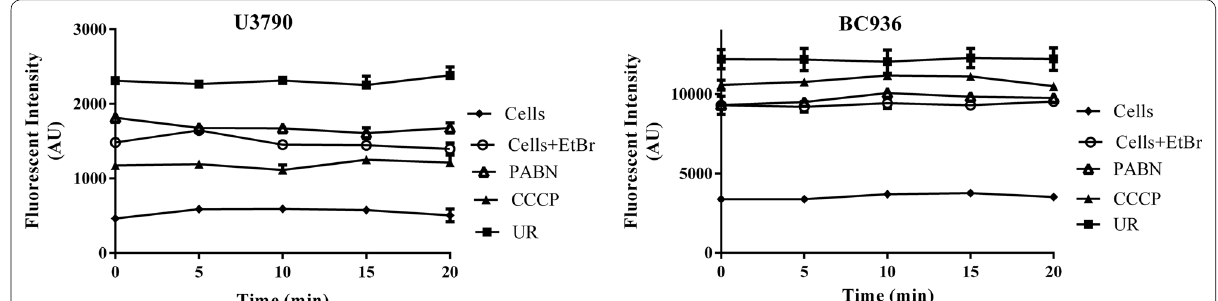
Fig. 4 Ursolic acid inhibits efflux pump in colistin resistant clinical isolates K. pneumoniae BC936 and E. coli U3790. The deenergized cells of K. pneumoniae BC936 and E. coli U3790 were treated with ursolic acid (UR) for 1 h. The cells were then reenergized with glucose and residual fluorescence of EtBr was measured for a time period of 0–20 min. Phenyl arginine beta naphthylamide (PABN) and Carbonyl cyanide m-chlorophenylhydrazine (CCCP) were maintained as positive controls (Filled diamonds—untreated cells; Empty circles—cells